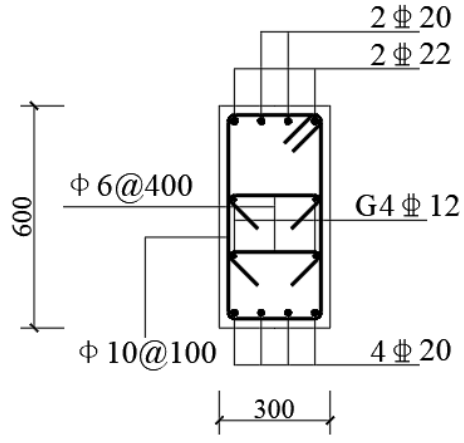
Figure 7. Reinforcement of the precast RC beam.